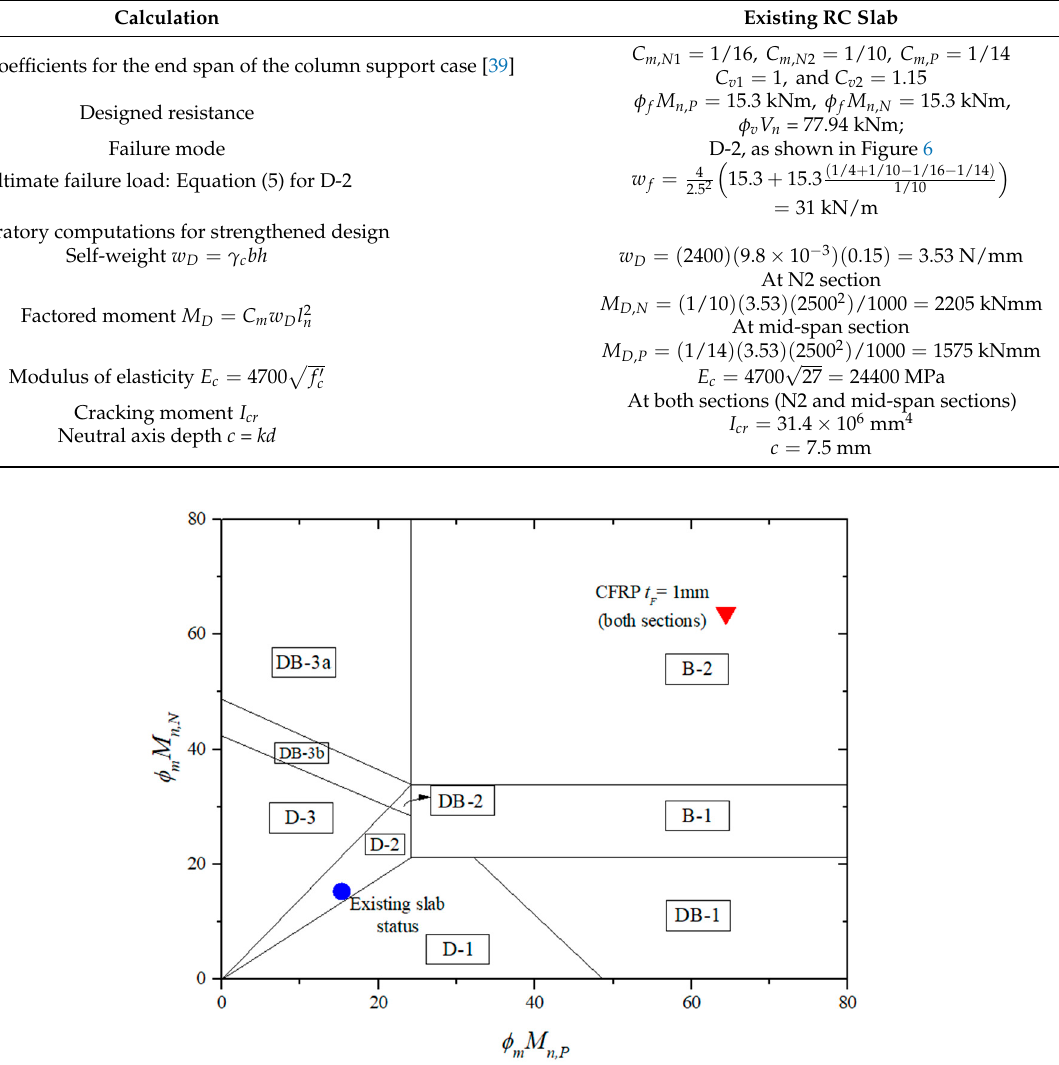
Table 3. Calculation of the existing RC slab.